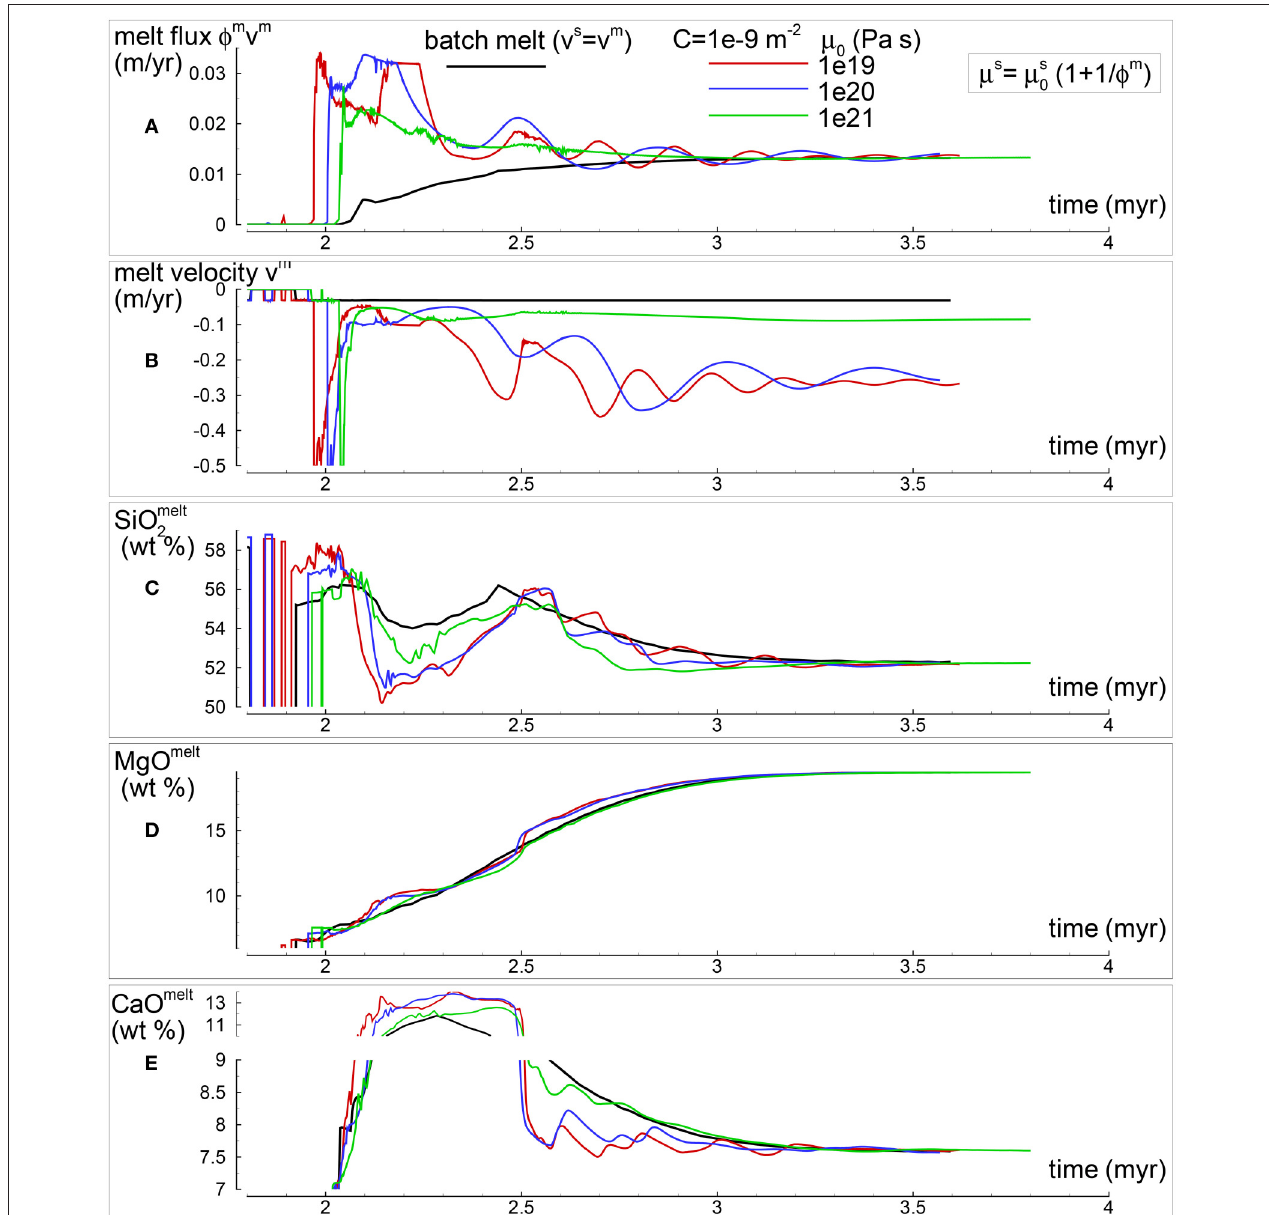
FIGURE 8 | Variation of selected melt properties over time at the top side of the simulation for three models with µ s = µ s 0 (1 + 1 /φ m ). The permeability constant is C = 10 − 9 m − 2 , µ s 0 is set to 10 19 , 10 20 , 10 21 Pa s. For comparison the results from the batch melting model are also reported in the plot. (A) Melt flux ( φ m v m ). (B) Melt velocity (m/yr). (C) Melt composition: SiO 2 (wt %). (D) Melt composition: MgO (wt %). (E) Melt composition: CaO (wt %). Complete data can be found in PHASE3-P.BRC4-5.DAT , PHASE3-P2.YRC14.DAT , PHASE3-P2.YRC13.DAT and PHASE3-P2.YRC10.DAT (zip file max-front1-data2.zip